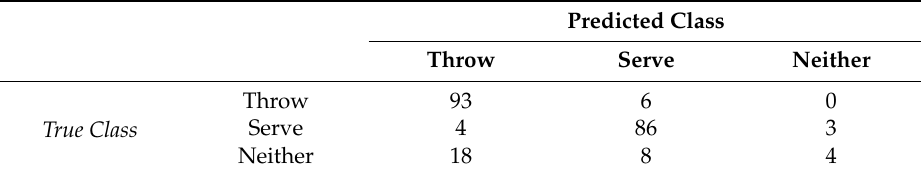
Table 3. Confusion matrix for the sport activity classifier over validation dataset (randomized counts and order, and blinded).